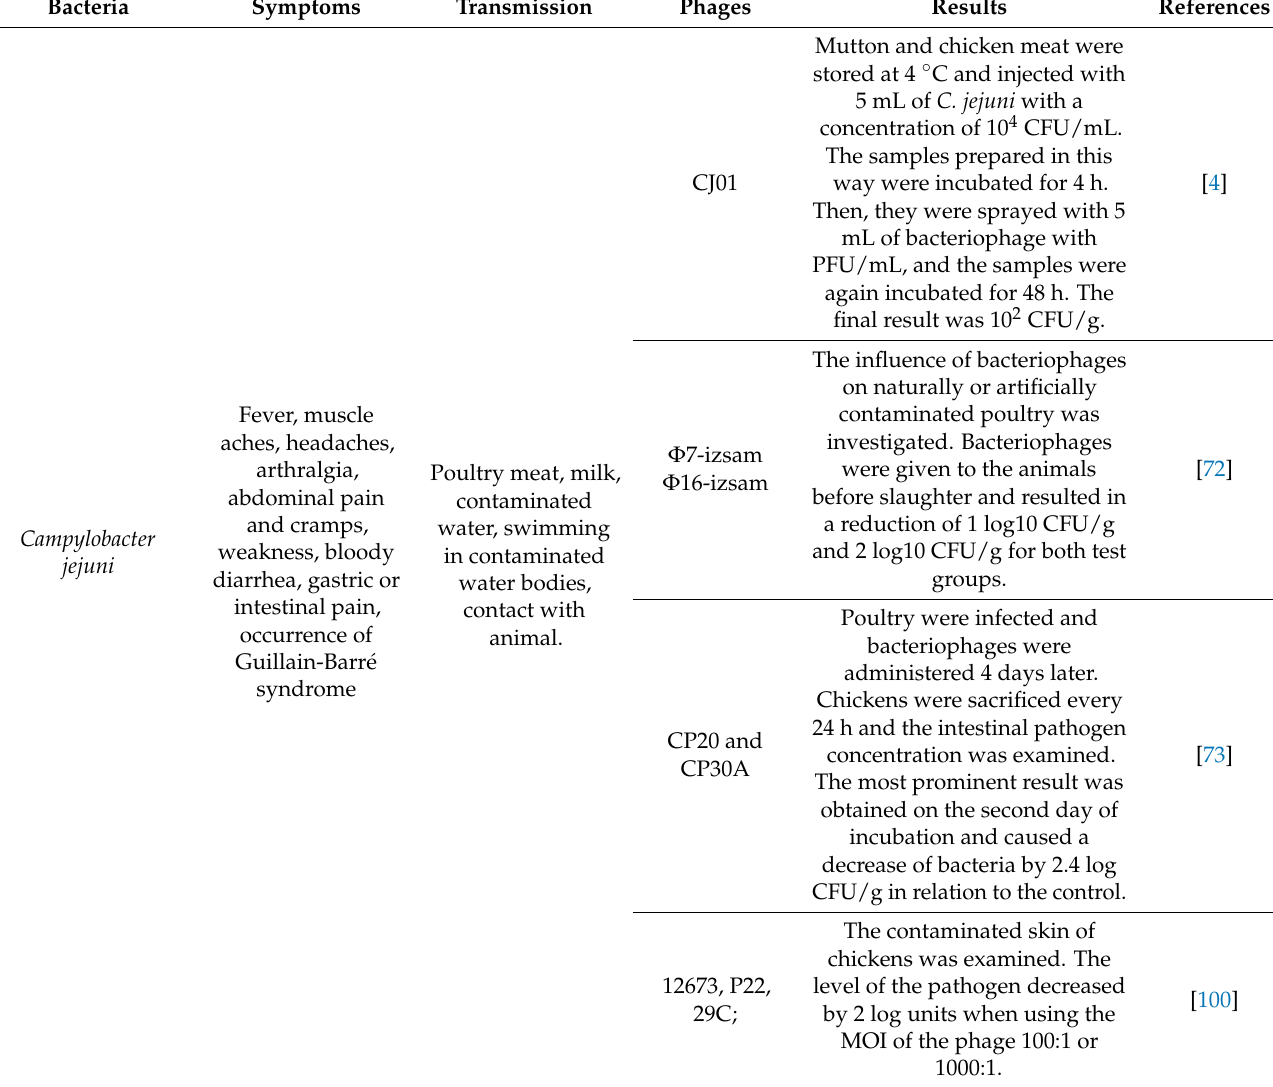
Table 1. Exemplary studies on bacteriophage use against selected foodborne